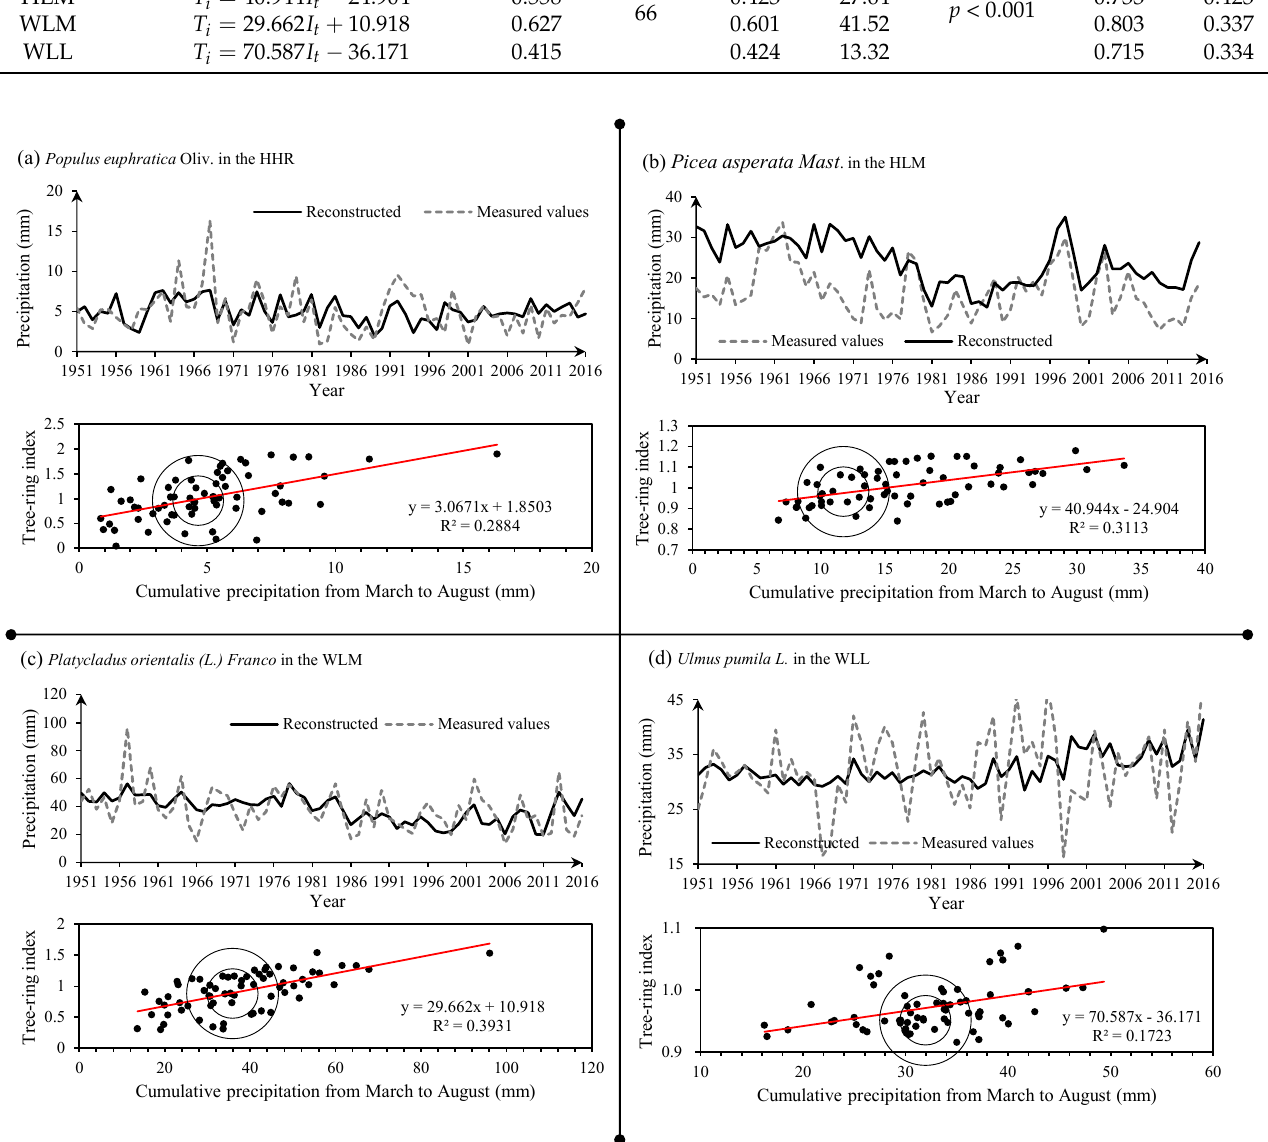
Figure 6. Comparison of reconstructed and measured values for growth-season precipitation and dispersion graphs of tree-ring chronology and accumulated precipitation from March to August in different areas.